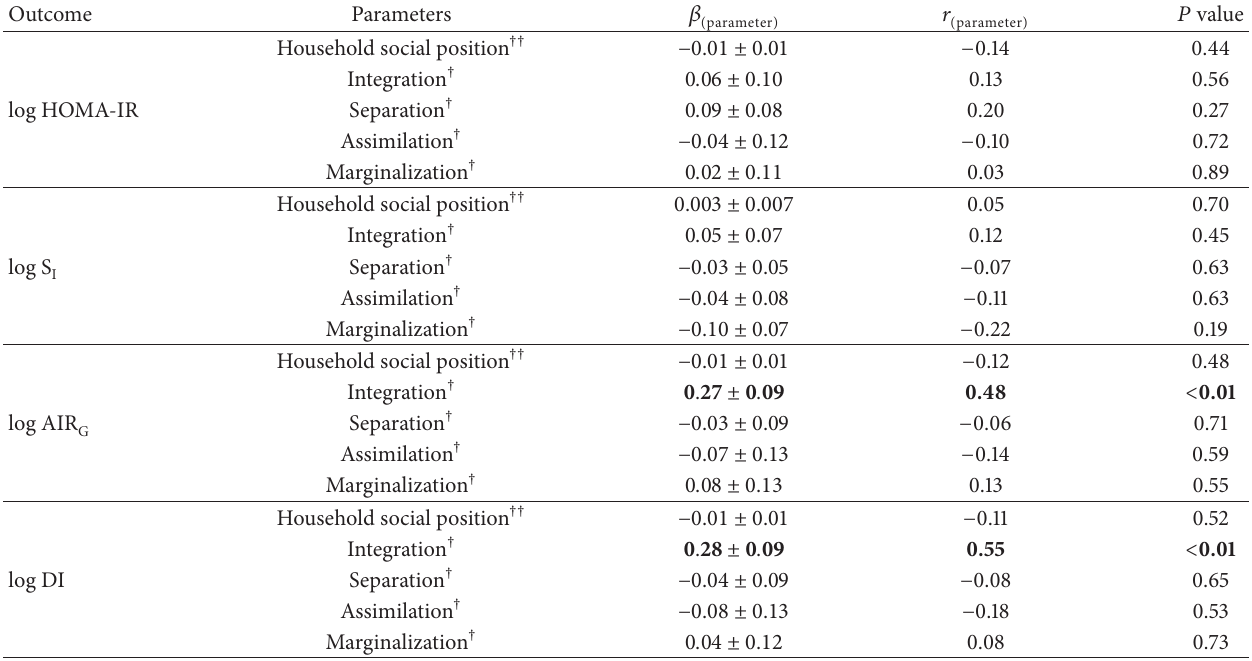
Table 3: Results of multiple regression analysis for African-American children and adolescents ( 𝑛 = 34 ). Outcome